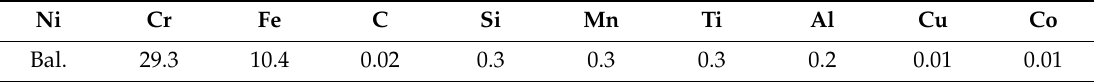
Table 1. Chemical composition of Alloy 690TT tubes (wt.%).